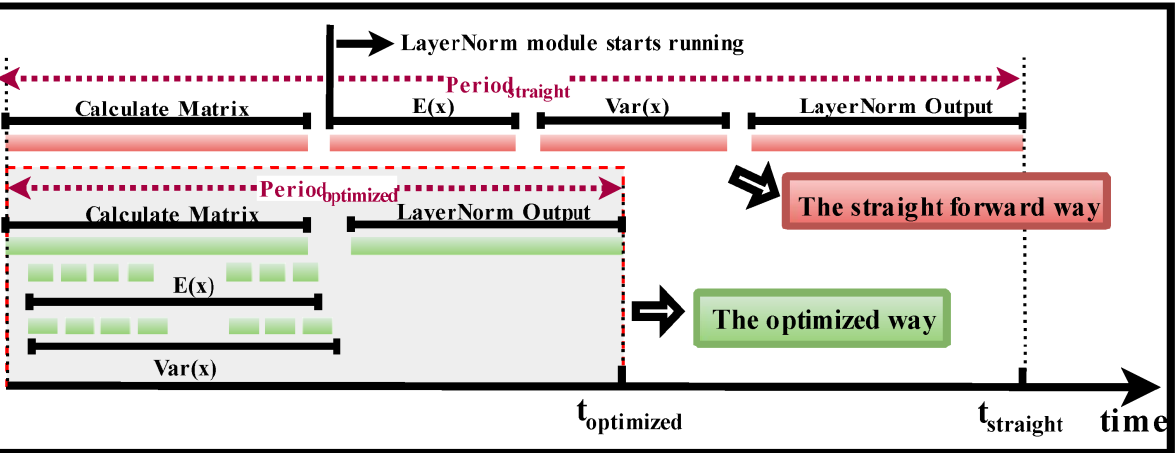
Figure 5. Timing diagram of LNC